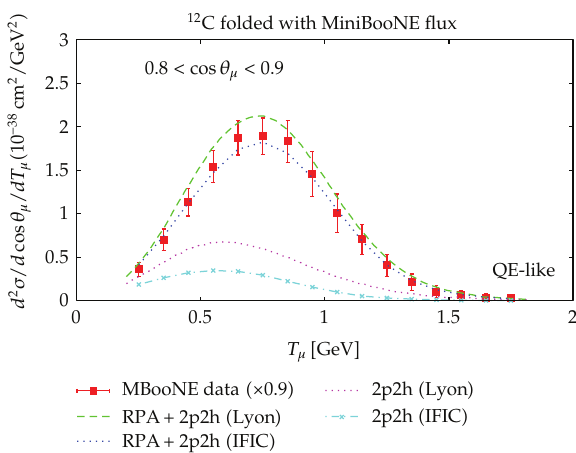
Figure 4: MiniBooNE flux-averaged CC quasielastic ν μ − 12 C double di ff erential cross section per neutron for 0 . 8 < cos θ μ < 0 . 9, as a function of the muon kinetic energy. Experimental data from (cid:6) 12 (cid:7) are multiplied by 0.9. In all the cases M A ∼ 1 .